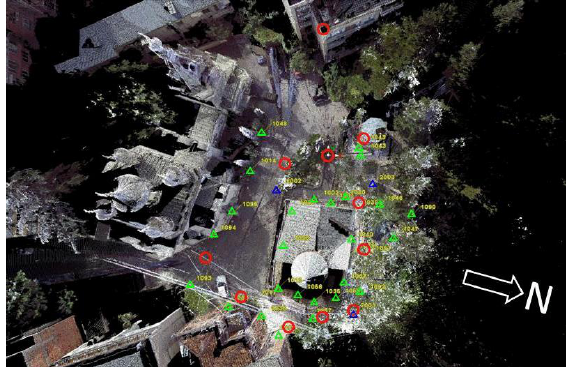
Figure 4. Overview of the registered Faro total point cloud with distribution of positions (red) and target marks (paper marks green, profit targets blue)